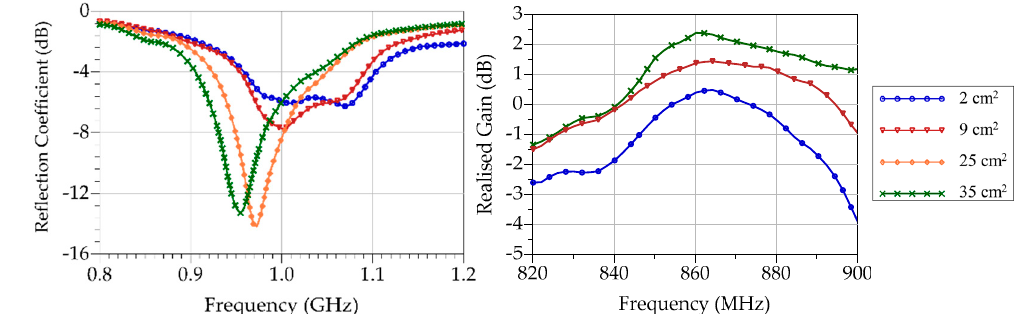
Figure 4. Effect of varying the ground plane’s size on a 0.67 λ -length monopole’s measured bandwidth ( left ) and realised gain ( right ).